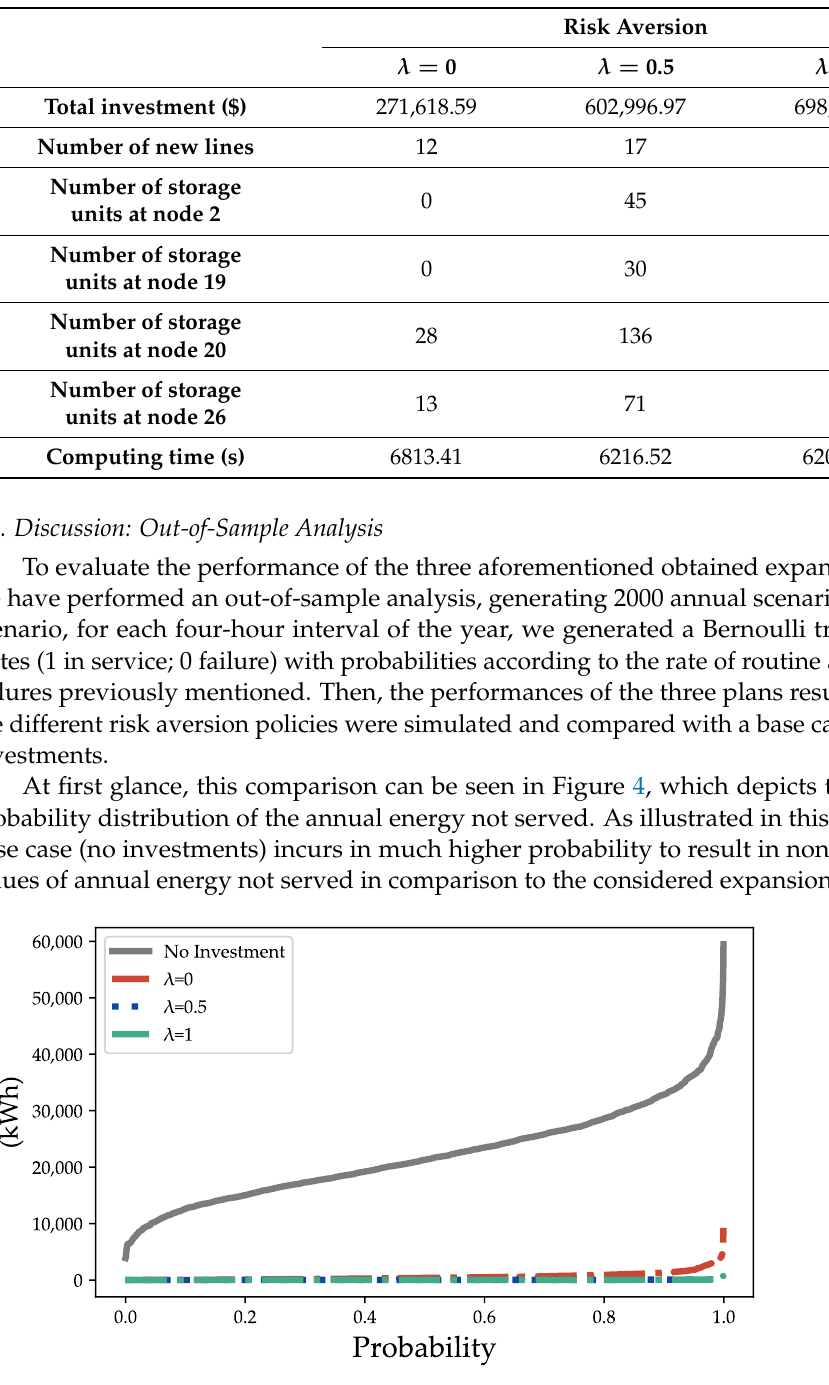
Figure 4. Out-of-sample analysis—Inverse probability distribution of the annual energy not